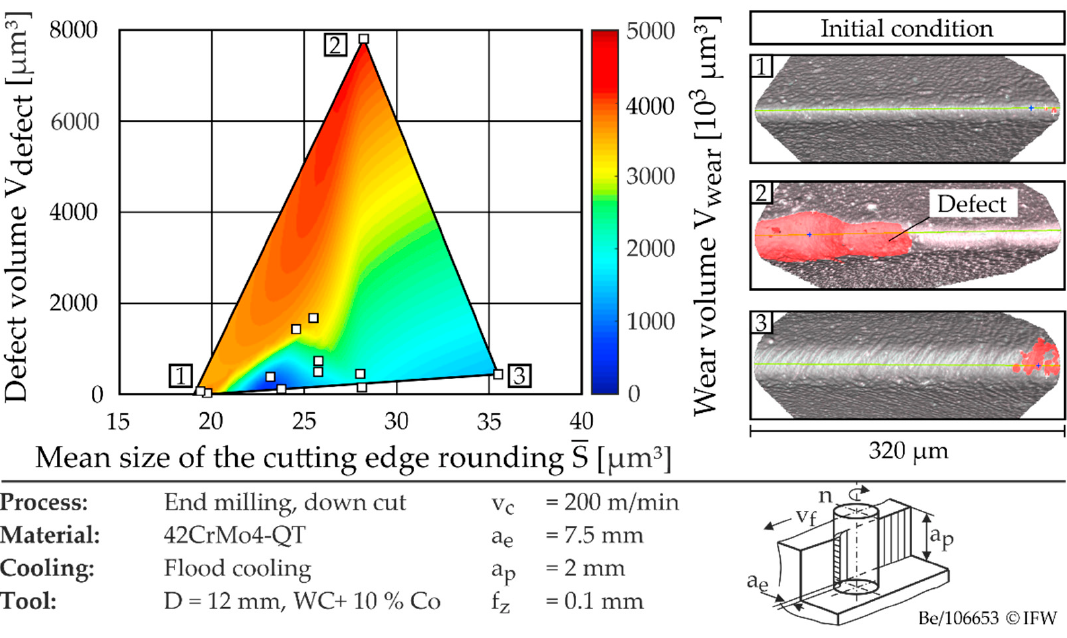
Figure 13. Coefficient of determination of the derived relationships between wear volume and the potential edge chipping parameters.